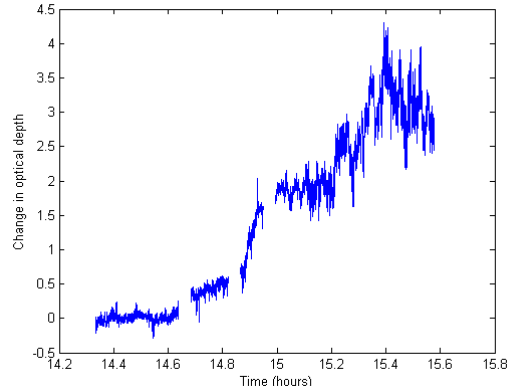
Fig. 13. Plot of change in optical depth versus time measured at 197GHz given as − 2 × ln (A norm (t)) where the amplitude is nor- malized to the amplitude just before the storm hit. Outages were caused by software problems that necessitated manual